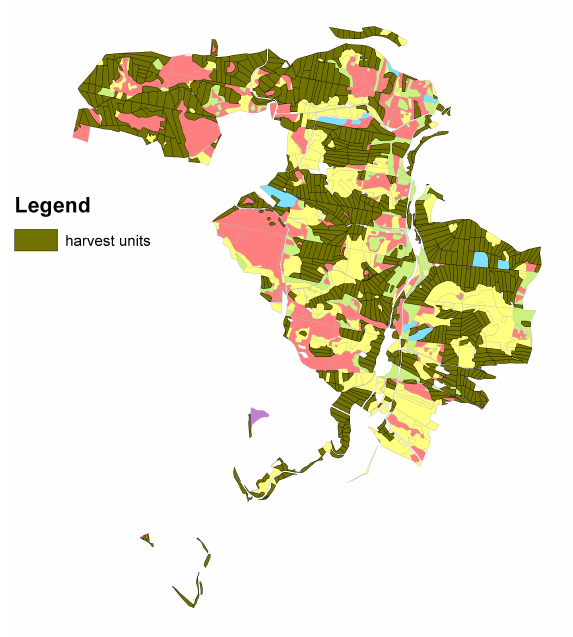
Figure 7. The potential harvest units for 3 planning